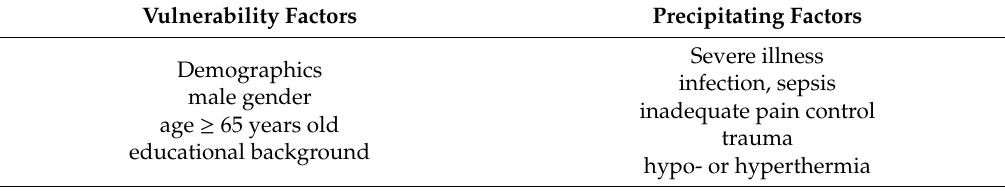
Table 1. Vulnerability and precipitating factors for delirium [23,24,27,28,29].